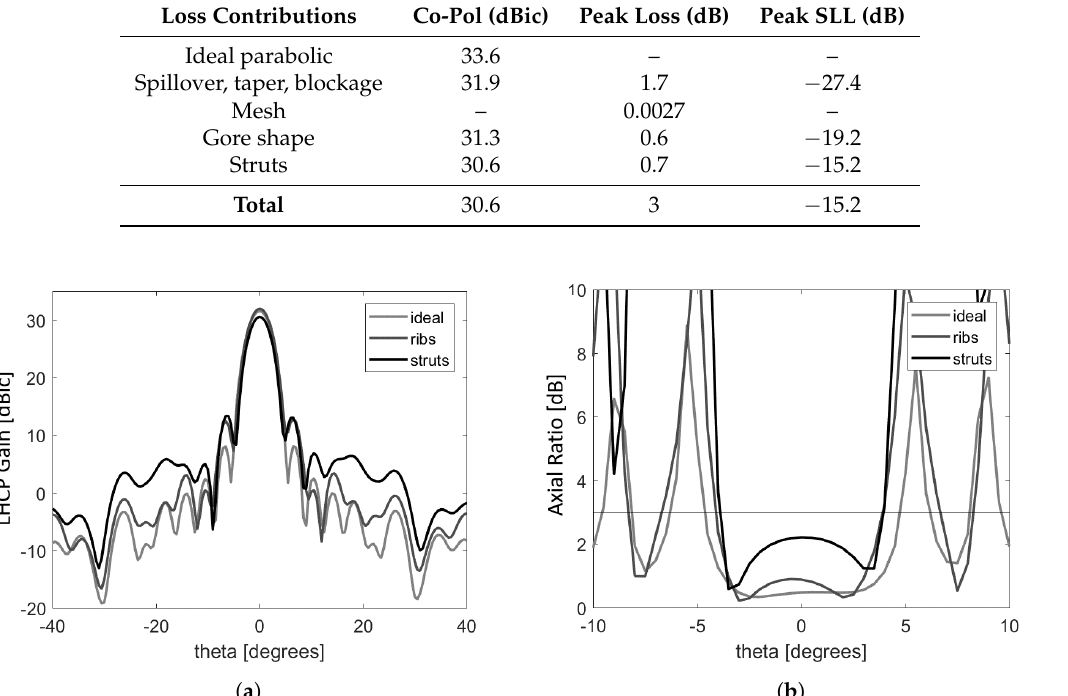
Figure 7. Simulated antenna pattern radiation accounting different elements contribution at center frequency: ( a ) co-polarized gain, and ( b ) axial